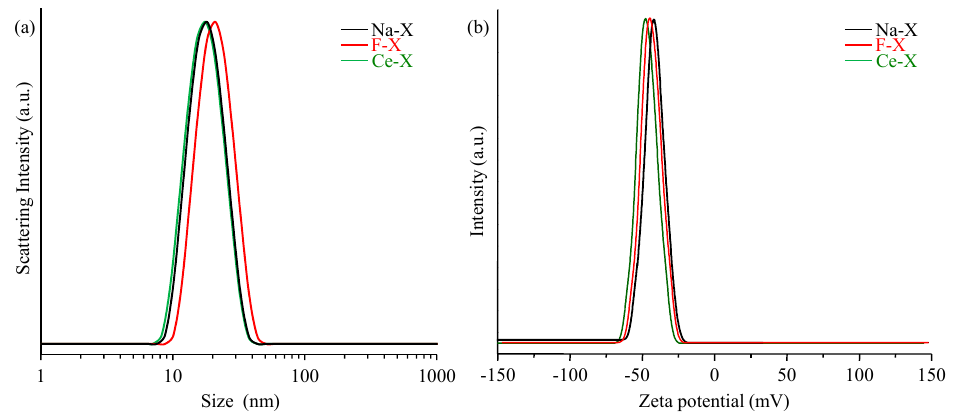
Figure 3. ( a ) Dynamic light scattering (DLS) and ( b ) zeta potential curves of as-synthesized Na-X, fluorinated zeolite F-X, and cerium ion exchanged Ce-X zeolites.